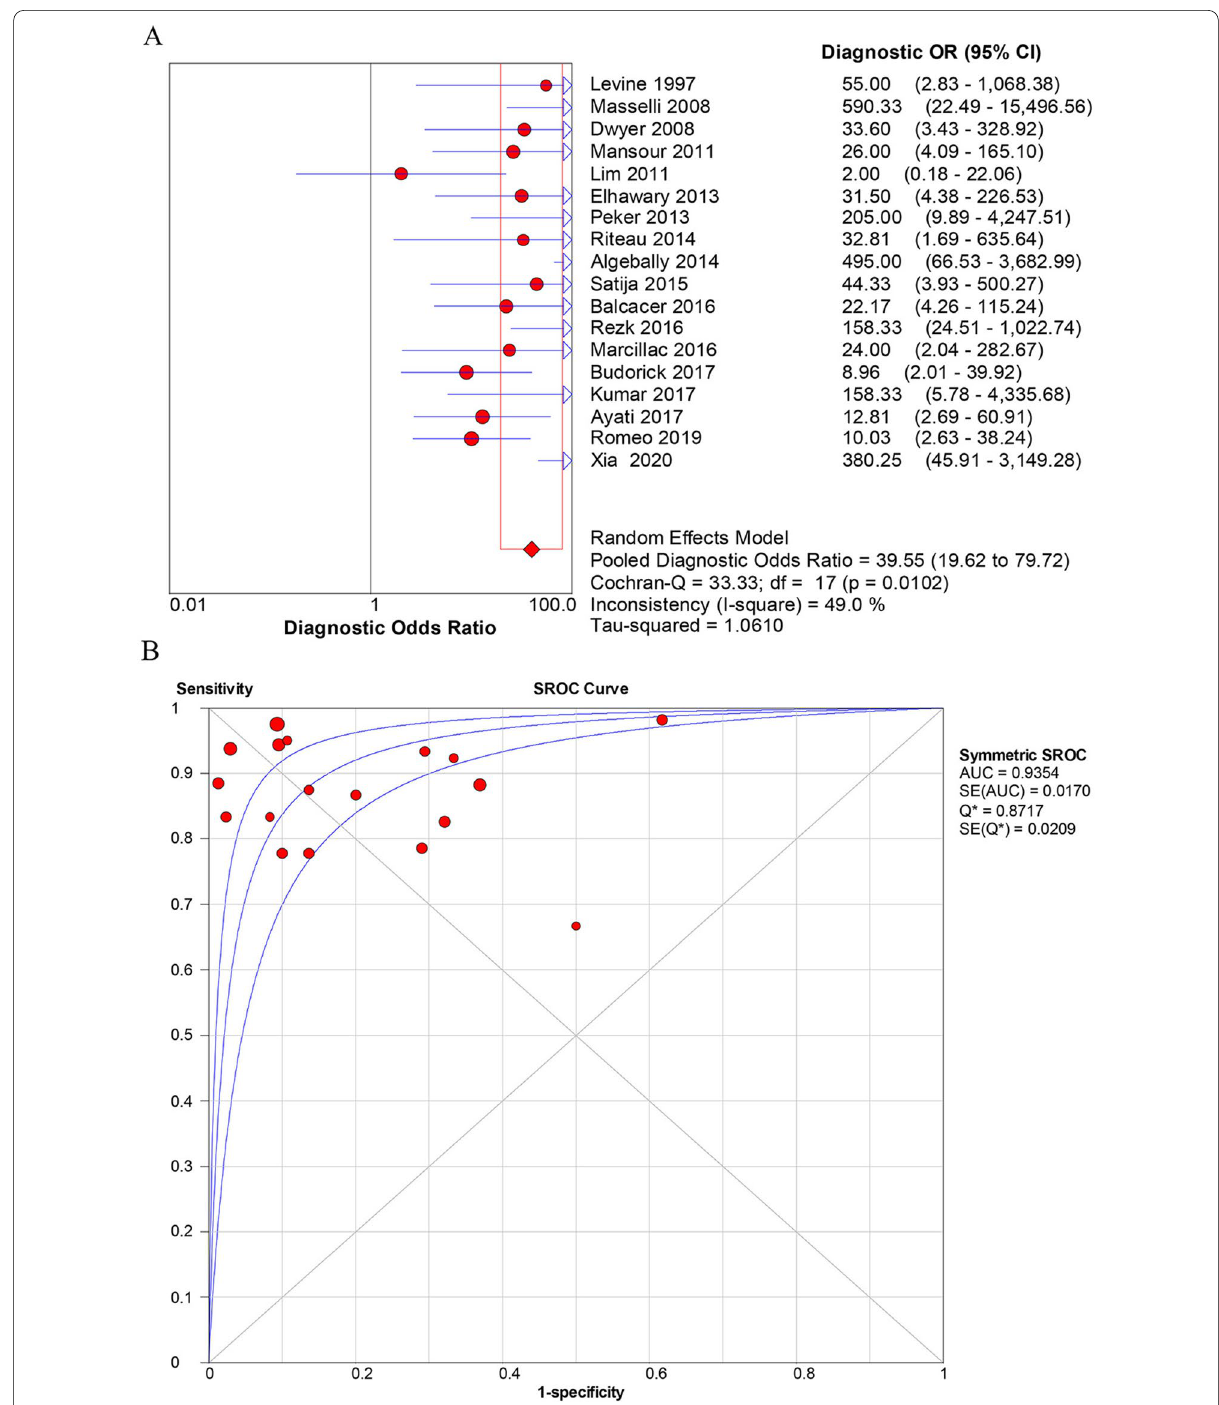
Fig. 4 The diagnostic performance of ultrasonography (US) for the prenatal identification of placenta accrete spectrum disorder (PAS) based on the ( A ) forest plots of overall diagnostic odds ratio (DOR) and ( B ) summary receiver operating characteristic (SROC) curve. The weight of each study is reflected by the size of data points. AUC, area under the curve; SE, standard